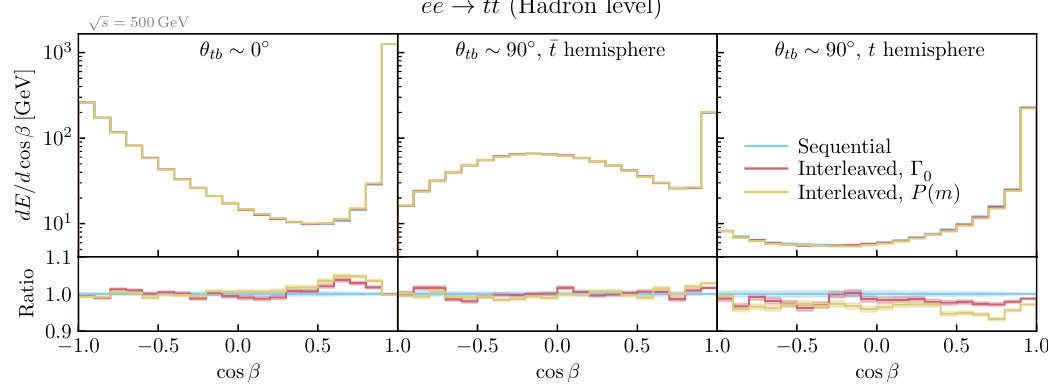
Figure 9: Hadron-level energy distribution in leptonic e + e − → t ¯ t events at (cid:112) s = 500GeV, as a function of the angle from the b jet, for (upper pane) events in which the b quark from the top-quark decay was emitted “forwards” (with > 0.9) and (lower panes) at right angles (with sin θ cos θ tb divided into two hemispheres, cf. fig.